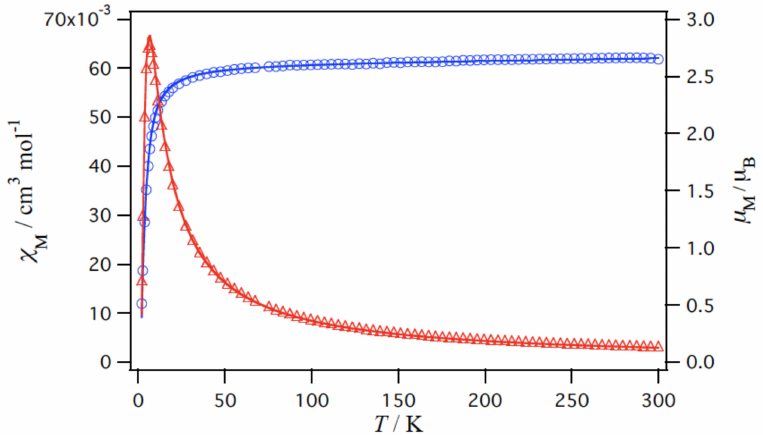
Figure 6. Temperature dependence of magnetic susceptibility χ M ( ∆ ) and magnetic moment µ eff ( ◦ ) of [Cu 2 ( L 7 ) 2 ](ClO 4 ) 2 ( 7